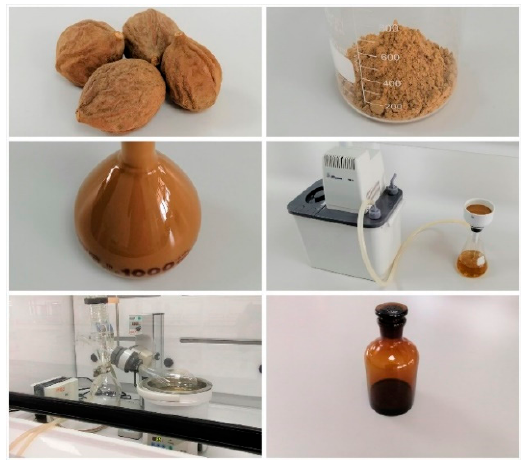
Figure 2. Preparation of Terminalia bellirica fruit extract.